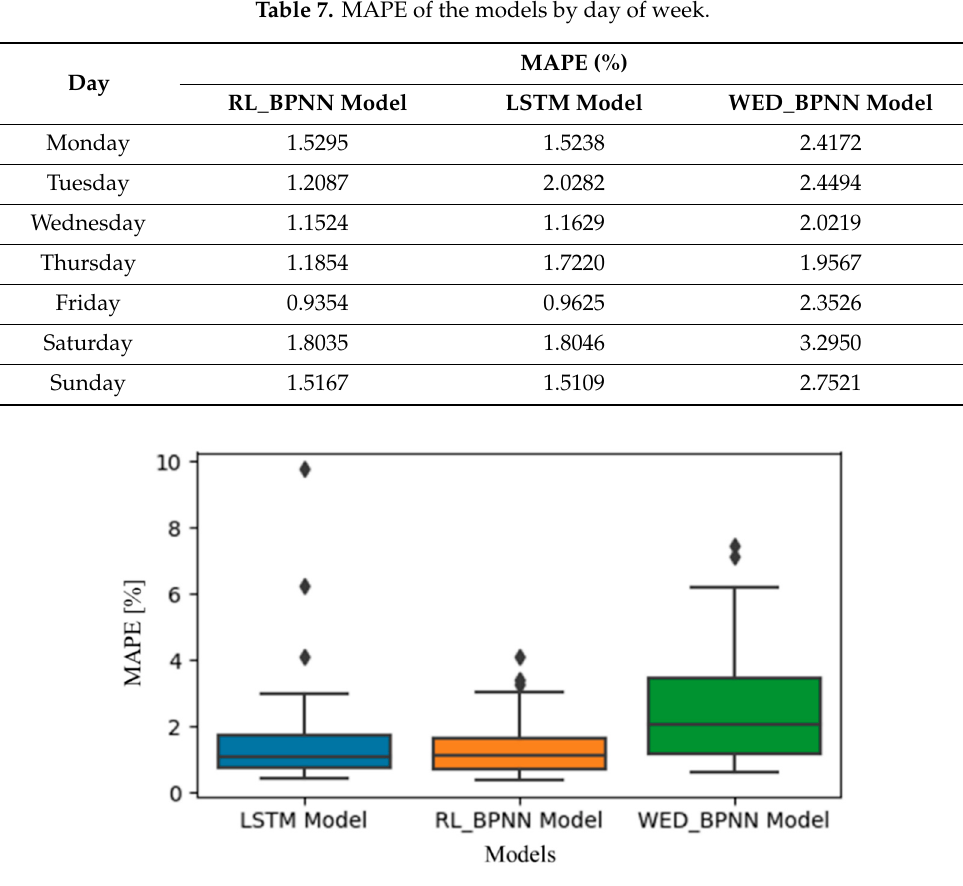
Figure 14. MAPE of the models by day of week. Table 6. MAPE of the models during March and April 2018.